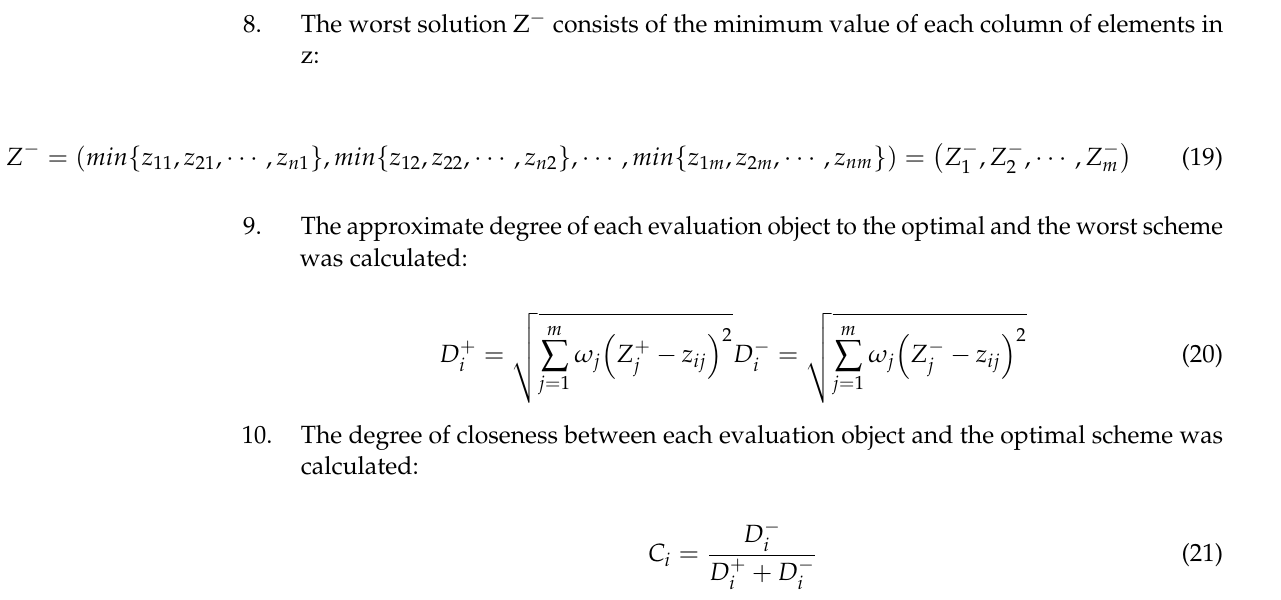
10. The degree of closeness between each evaluation object and the optimal scheme was calculated: